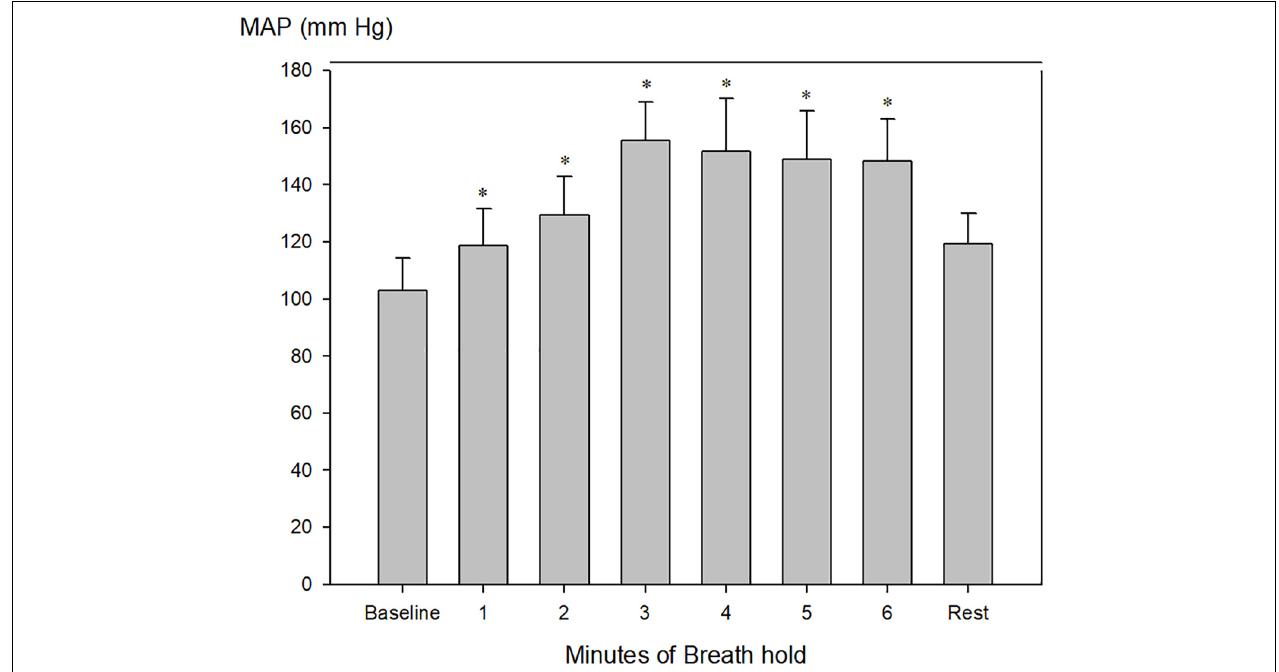
FIGURE 6 | Invasively measured mean arterial blood pressure (MAP) during pool apnea. After 2 min of breath hold mean arterial blood pressure increased every minute compared to rest from 103 ± 4 to a maximum of 155 ± 6 after 3 min of apnea ( ∗ P < 0.001 compared to baseline, n =